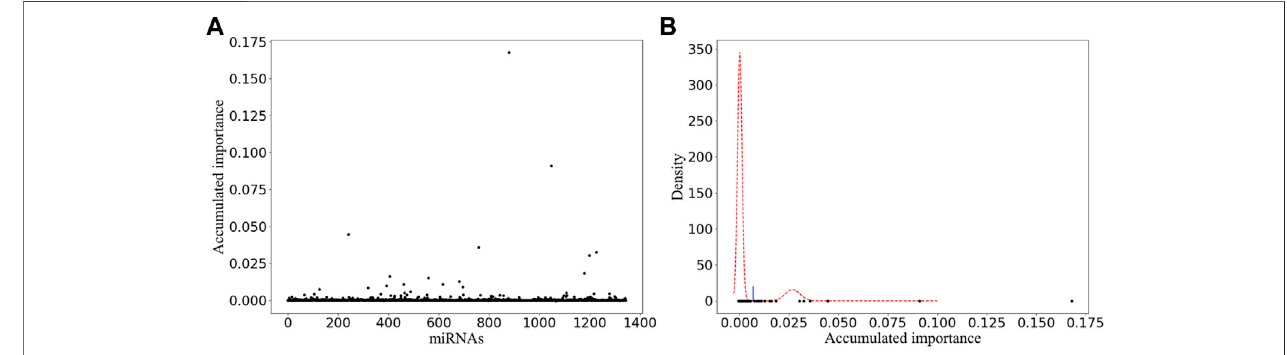
FIGURE2 | Variable selection result of one-time sample division. (A) Obtained scatter plot. Its horizontaland verticalordinates correspond tothe labels of miRNAs and their accumulated scores, respectively. (B) Corresponding miRNA selection result. Its horizontal and vertical ordinates refer to the accumulated scores and the corresponding probability density, respectively.